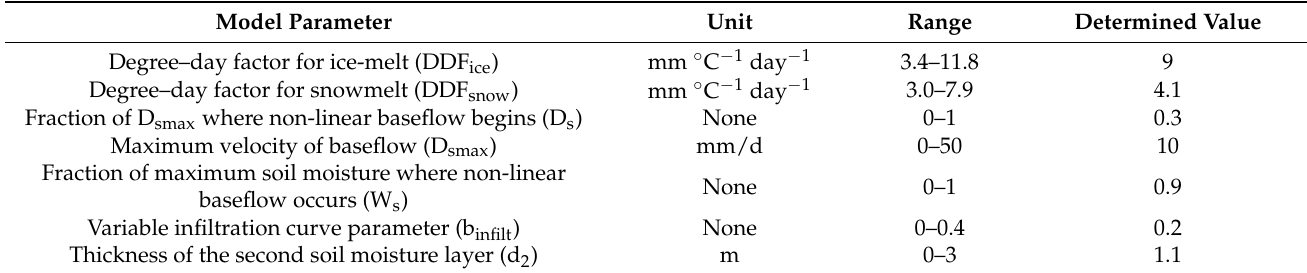
Table 4. Summary of model parameters, ranges, and calibrated values used in VIC-glacier model over the